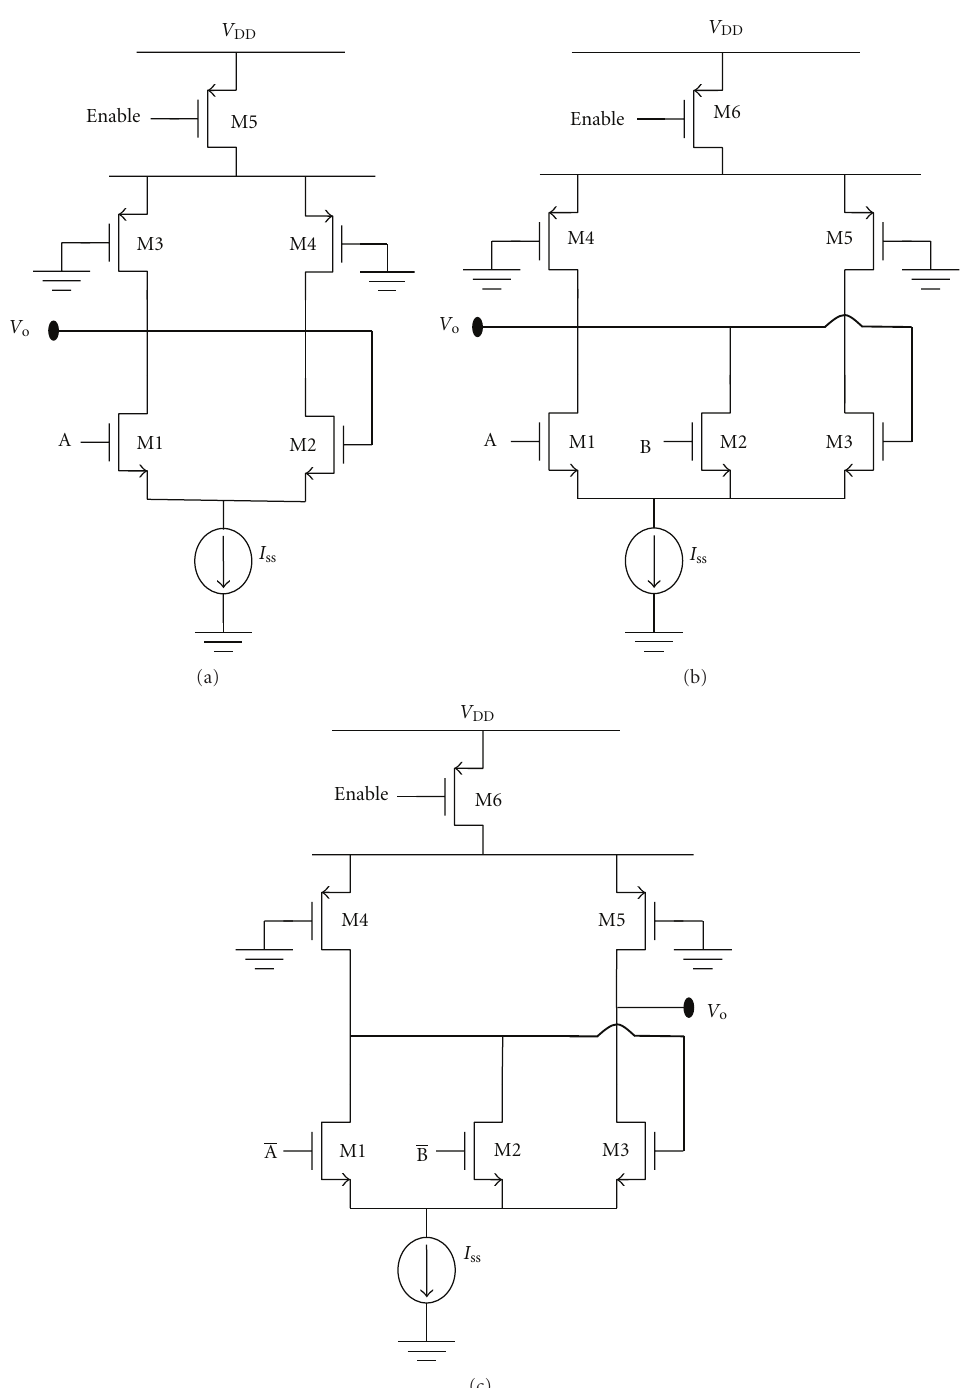
Figure 5: Sleep transistor based PFSCL tristate circuits, (a) bu ff er/inverter, (b) 2-input NOR, and (c) 2-input NAND.